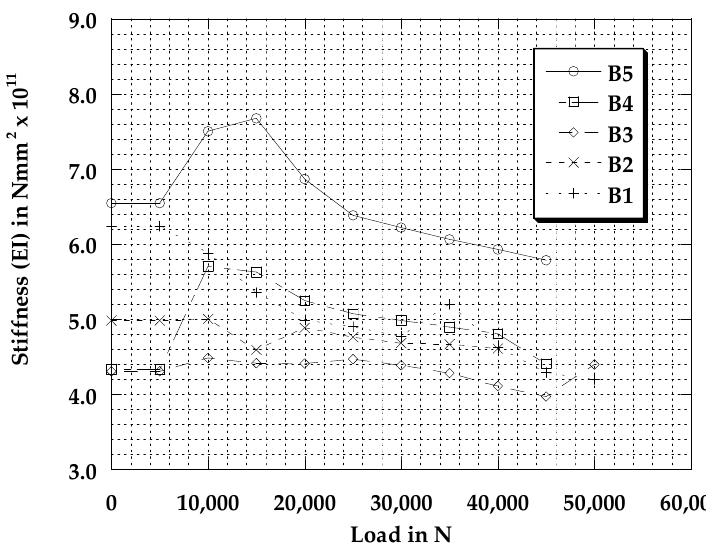
Figure 9. The load and deflection curves at mid-span for series I and II tests.